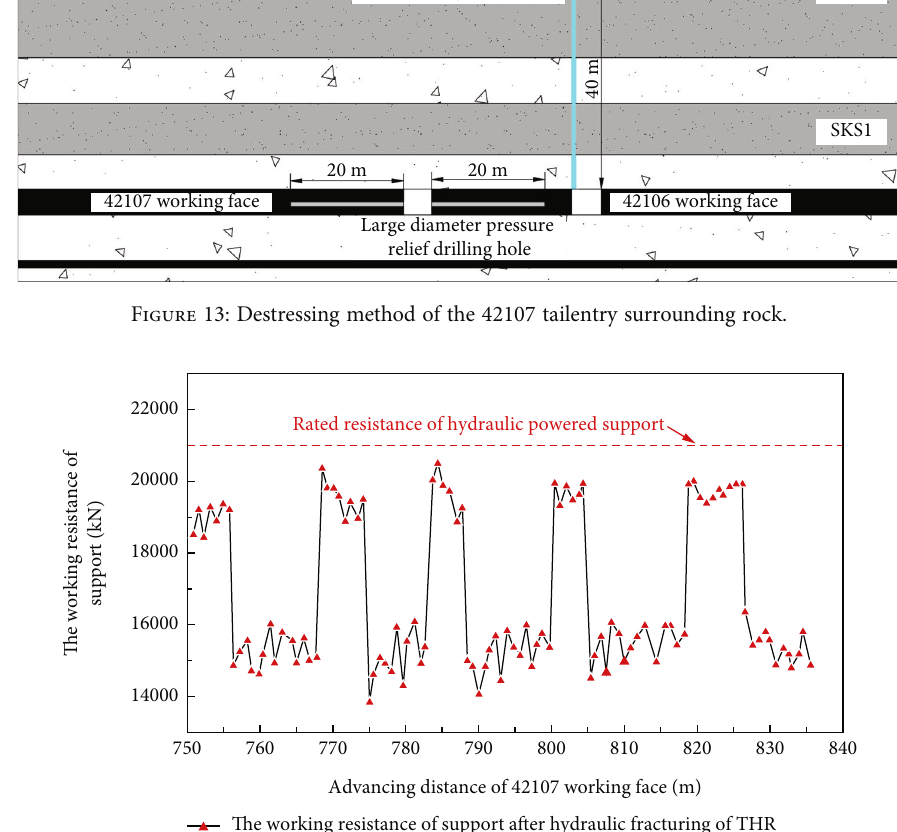
Figure 14: Periodic weighting interval of working face 42107 after hydraulic fracturing of thick hard